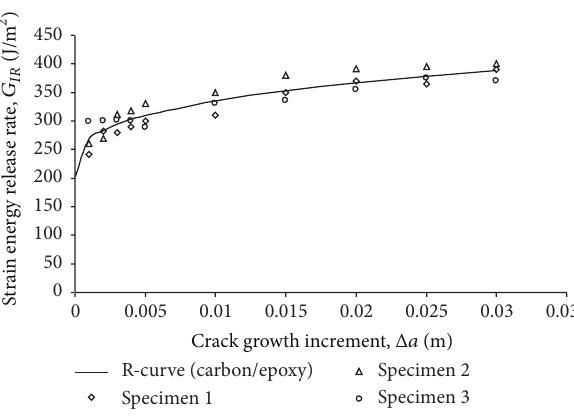
Figure 2: R-curve ( 𝐺 𝐼𝑅 = 1798 + 1286(Δ𝑎) 0.29 ) of DCB specimens made of carbon/PEEK.